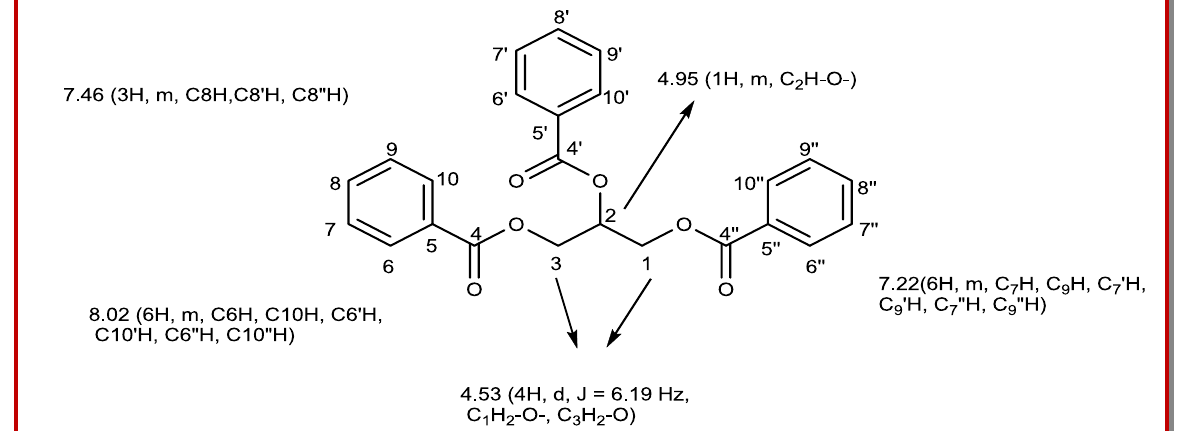
Figure 1: 1 H-NMR chemical shifts of compound